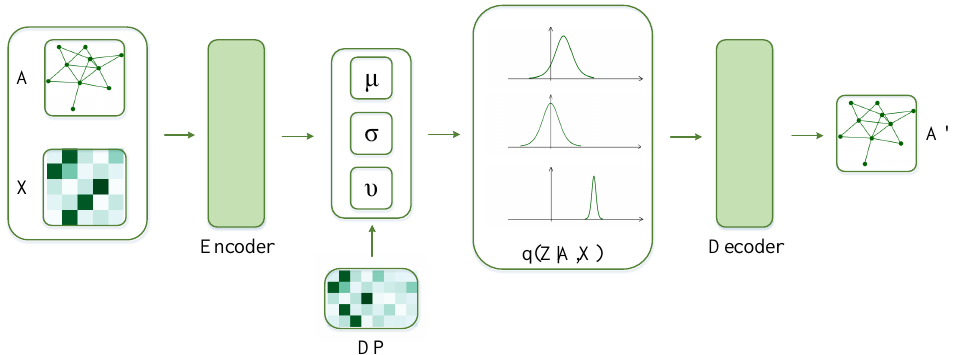
Figure 3. The architecture of the DP-St GVAE. The encoder is a graph convolutional neural net- work that integrates the network structure A with node feature X and, by extension, generates the node representation Z . The decoder reconstructs a graph from the inner product of the node representation Z